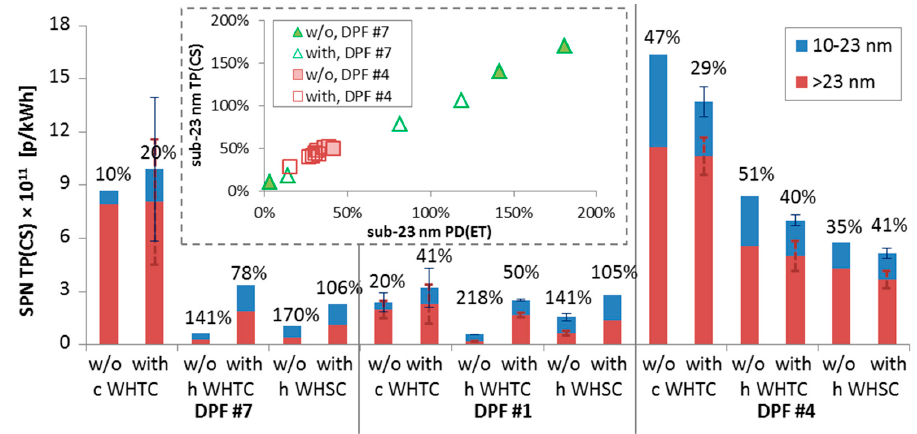
Figure 3. Solid particle number (SPN) emissions with and without the crankcase ventilation connected downstream of the aftertreatment devices, as measured with the “Golden” TP(CS) system for three diesel engines. Numbers give the additional 10–23 nm particles compared to the > 23 nm levels. Error bars show one standard deviation of 2–3 tests. The inset compares the sub-23 nm percentages of the TP(CS) and PD(ET) systems with and without the crankcase ventilation connected for DPF #4 and DPF #7. WHTC = World harmonised transient cycle; WHSC = World harmonised stationary cycle; h = hot; c = cold.